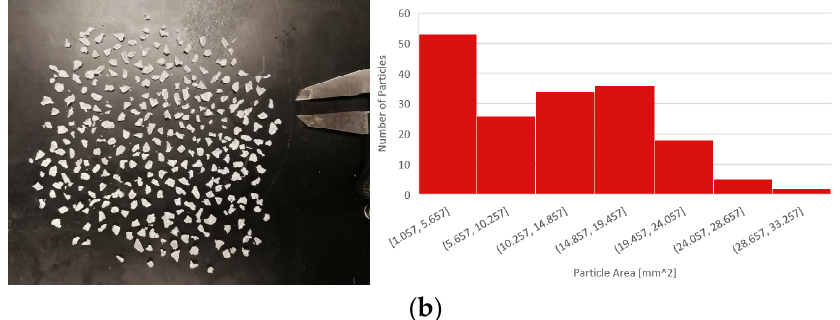
Figure 2. Recycled polycarbonate (PC) particles and size distribution, unsifted ( a ) and sifted ( b ).